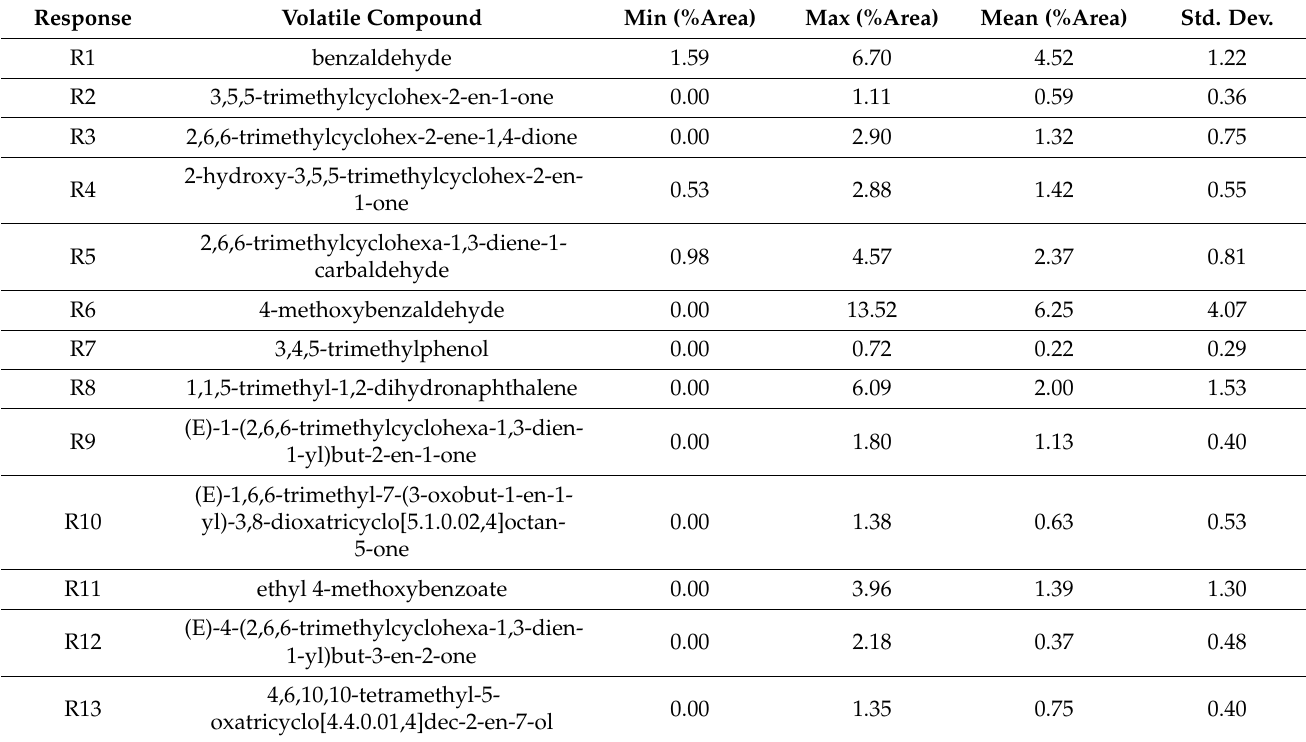
Table 3. Dominant volatile compounds (responses